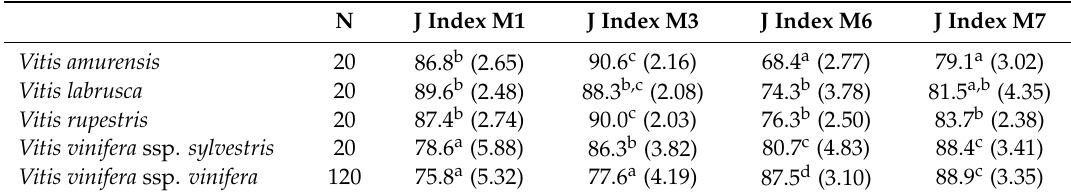
Table 3. Mean values of the J index in seeds of four species of Vitis , with four of the models used.